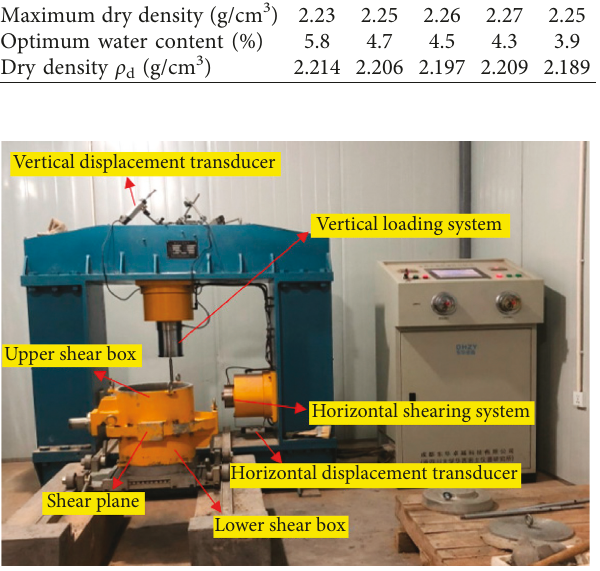
Figure 4: Photo of the large-scale direct shear test